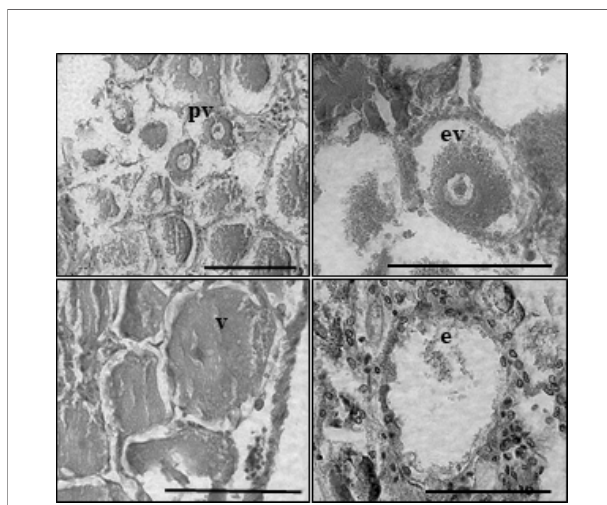
FIGURE 4 | Lightmicrographs ofhistologicalsections throughtheovaryof Segonzaciamesatlantica usingLeicaLeicaCTR600microscope,programLAS core. Previtellogenicoocytes(pv);earlyvitellogenicoocytes (ev); vitellogenicoocyte (v)andemptyoocyte(e).Scalebar =100 m